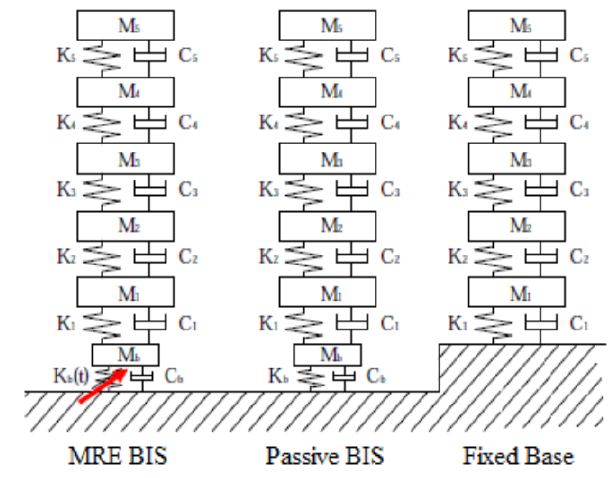
Figure 2. Building structure idealized representation.